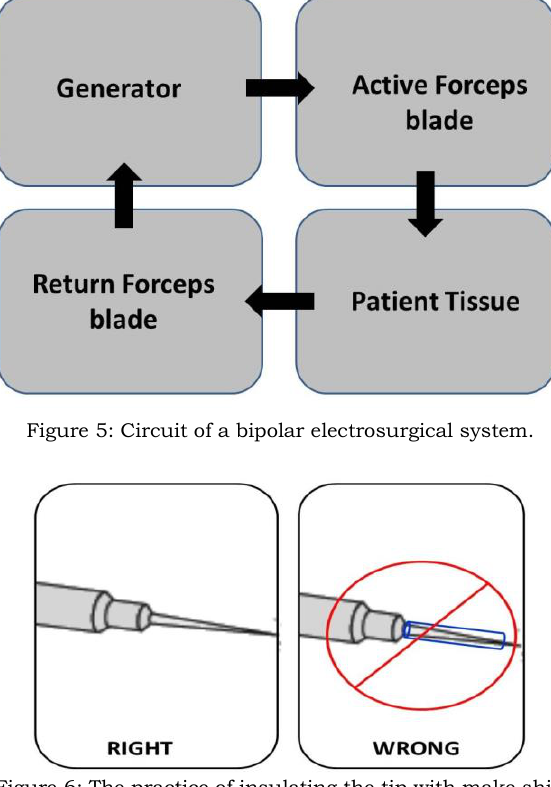
Figure 6: The practice of insulating the tip with make shift tubular insulators should be